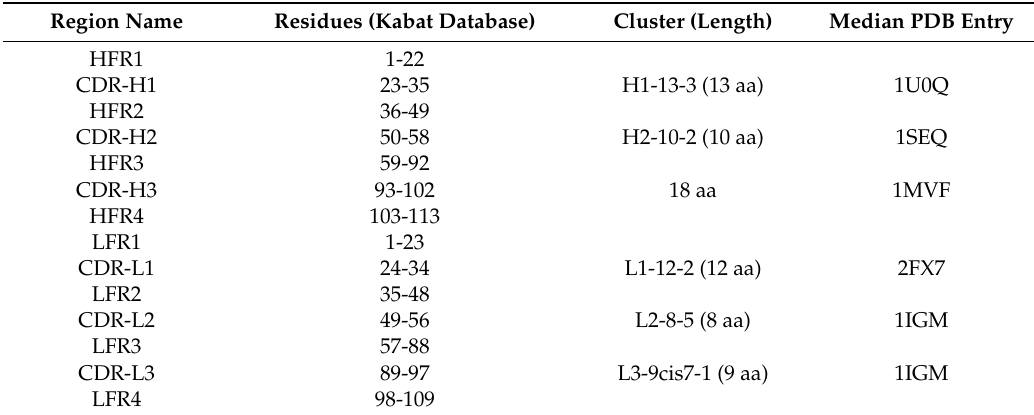
Table 3. Comparison of H- and L-loops of the netakimab Fab fragment with the canonical types (clustering according to [36]).